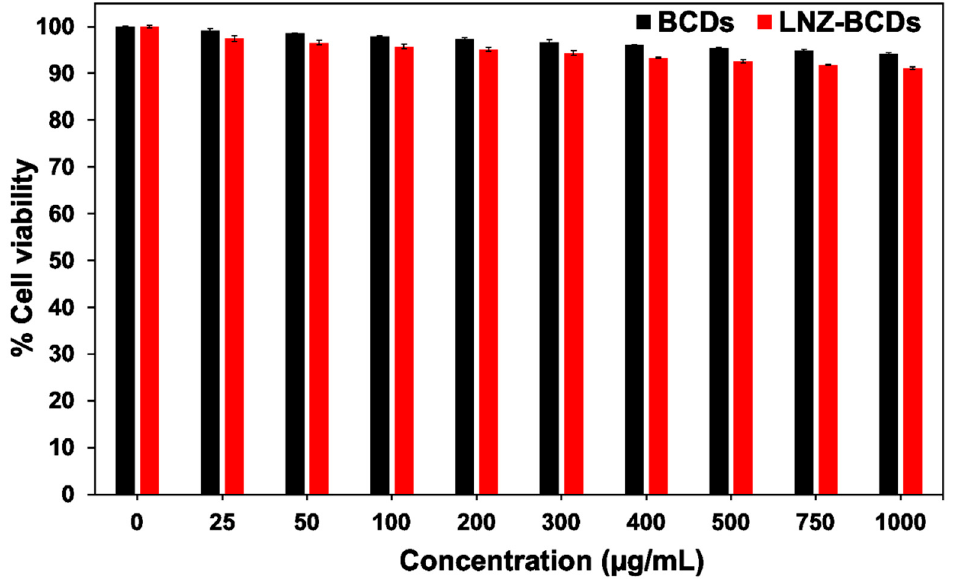
Figure 10. Cell viability percentage of HSF cell line against BCDs nano-biocarrier and LNZ − BCDs nano-bioconjugate at various concentrations for 24 h.